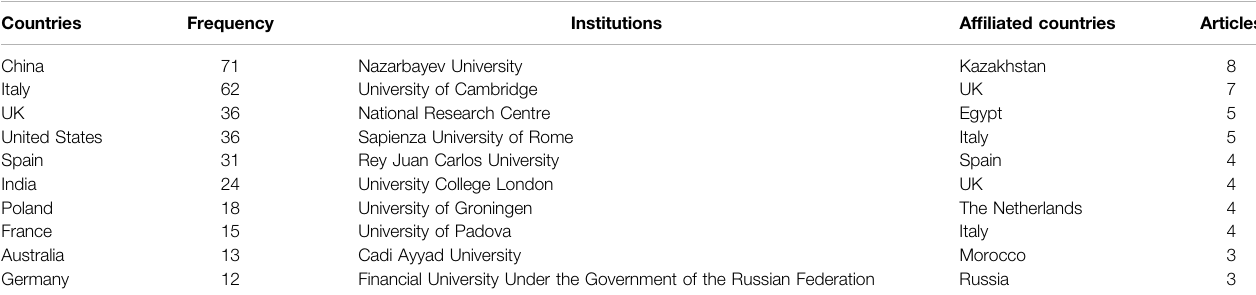
TABLE 4 | Distribution of countries and institutional af fi